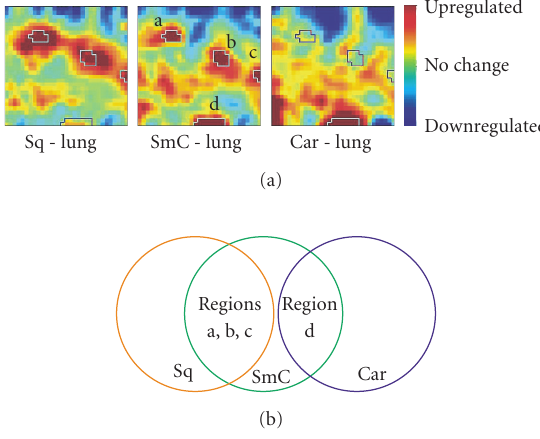
Figure 5: GEDI maps reveal a qualitative aspect in the quantitative di ff erence between tumor types with respect to expression of promi- nent marker genes. (a) Di ff erence maps were obtained by element- wise subtraction of the average metagene expression levels, averaged for all samples in the same diagnosis group of tumor tissues and normal tissues respectively. The circled regions a – d represent four “gene islands” containing the 5% most upregulated genes in SmC compared to normal lung. Color bar represents centroid values after subtraction. (b) Schematic of the qualitative relationship between 3 types of tumor samples: SmC appears to be the union set of Sq and Car with respect to the selected genes that are di ff erentially overex- pressed in SmC relative to normal